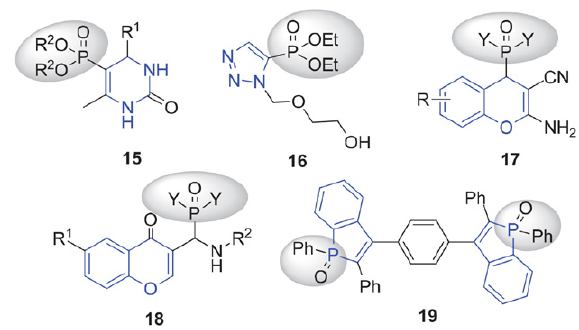
Figure 3. Biologically active phosphorylated heterocyclic com-